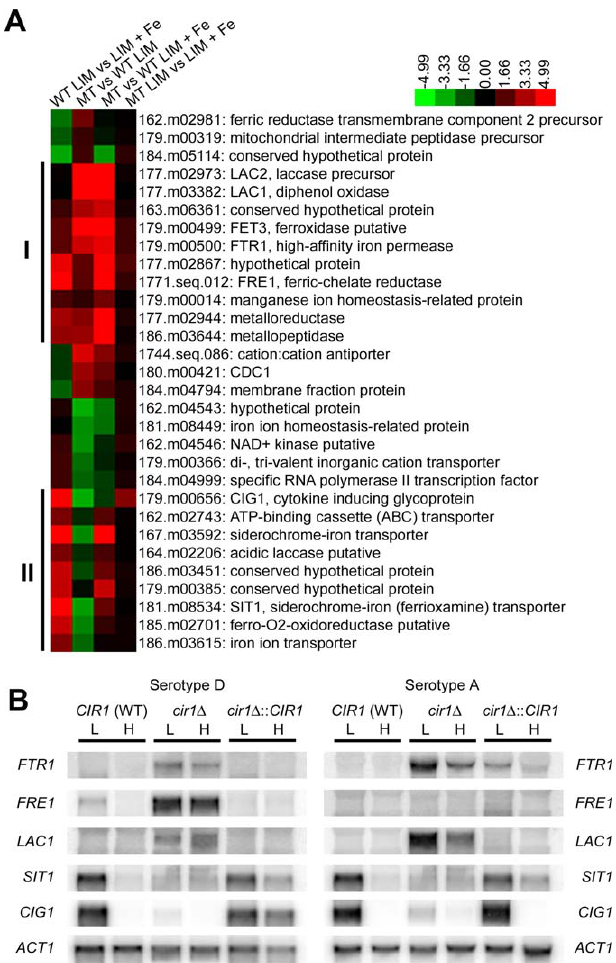
Figure 2. Cir1 Directly Regulates Genes Required for Iron Transport (A) Cluster analysis of genes required for iron transport show two patterns of differential expression in the cir1 mutant (serotype D), resulting in two main clusters (I and II). Columns represent the log- transformed ratio of the array data from the wild-type strain in low- versus high-iron medium (WT LIM vs. LIM þ Fe), the cir1 mutant versus the wild-type strain in low-iron medium (MT vs. WT LIM), the cir1 mutant versus the wild-type strain in high-iron medium (MT vs. WT LIM þ Fe), and the cir1 mutant in low- versus high-iron medium (MT LIM vs. LIM þ Fe). (B) RNA blot analysis to confirm differential expression of genes required for iron transport in both the serotype D and the serotype A strains grown in a low-iron medium (L) or high-iron medium (H). WT, wild type. DOI: 10.1371/journal.pbio.0040410.g002